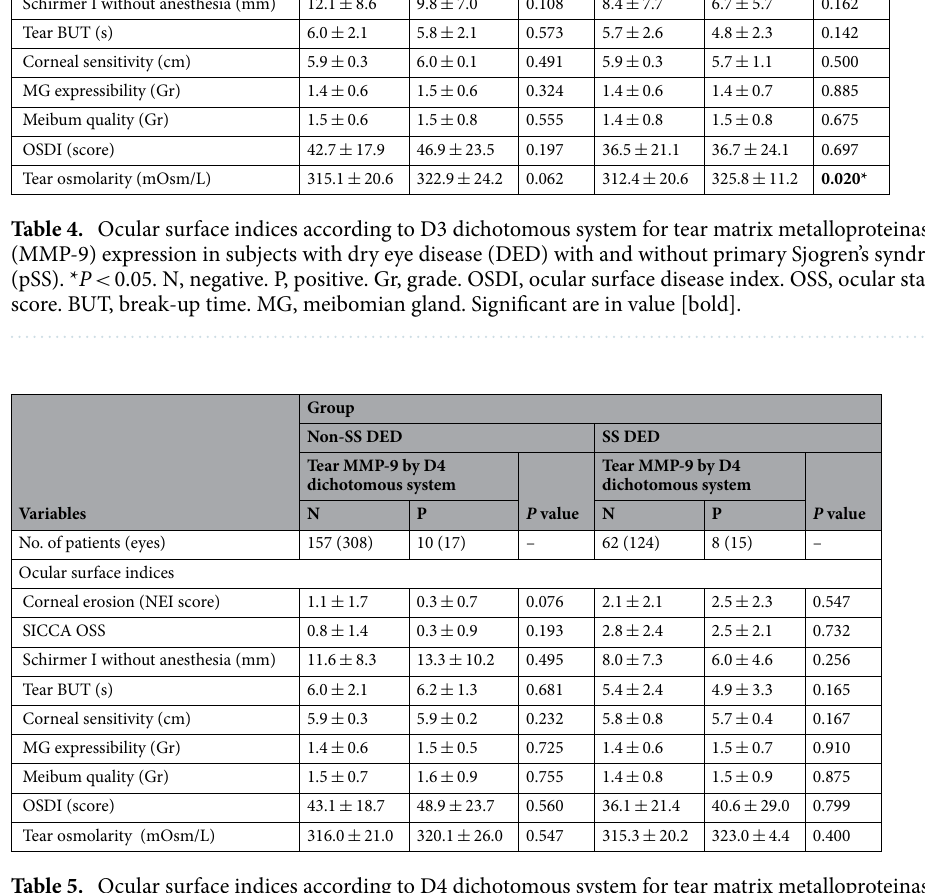
Table 5. Ocular surface indices according to D4 dichotomous system for tear matrix metalloproteinase 9 (MMP-9) expression in subjects with dry eye disease (DED) with and without primary Sjogren’s syndrome (pSS). N, negative. P, positive. Gr, grade. OSDI, ocular surface disease index. OSS, ocular staining score. BUT, break-up time. MG, meibomian gland.